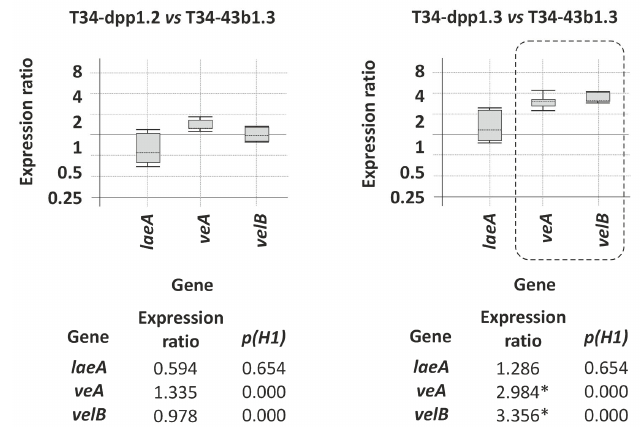
Figure 6. qPCR analysis of relative expression levels of genes related to regulation of circadian cycle: laeA , veA and velB , in transformants T34-dpp1.2 and T34-dpp1.3 versus levels observed in the control strain T34-43b1.3. In the graphic representation, those statistically significant differential expression data ( p < 0.05) are squared with dashed lines and numeric values were labeled with an asterisk (*) at the bottom of each graphic..